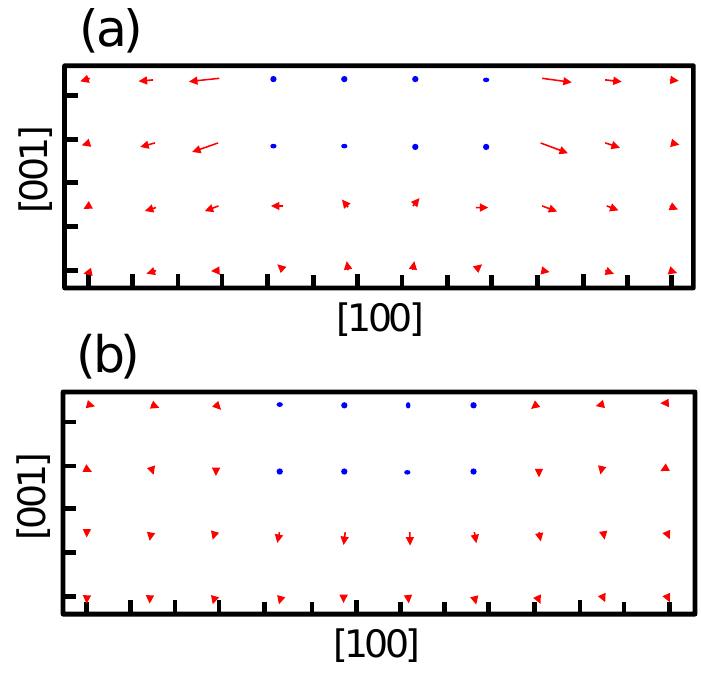
Figure 6. Movement of atoms around the precipitate with an ( a ) coherent and ( b ) semi-coherent interface via structure optimization. The blue points denote atoms in the precipitate region. The red arrows denote movements of atoms in the matrix region by the structural optimization from the ideal position of Fe atoms in bcc iron due to precipitation. The length is elongated by five times from the original for clarity. The tick mark spacing is 0.2 nm for both the horizontal and vertical